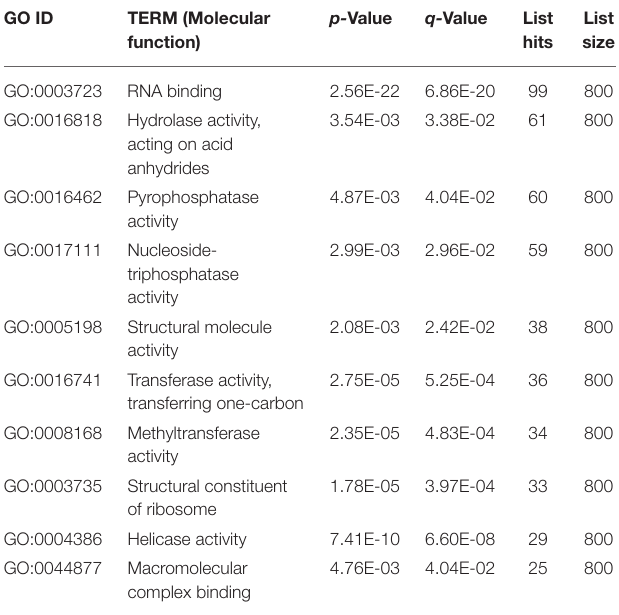
TABLE 1 | GO functional enrichment analysis of differentially expressed genes when A. flavus was treated with eugenol. p- Value q- GO ID TERM (Molecular function)